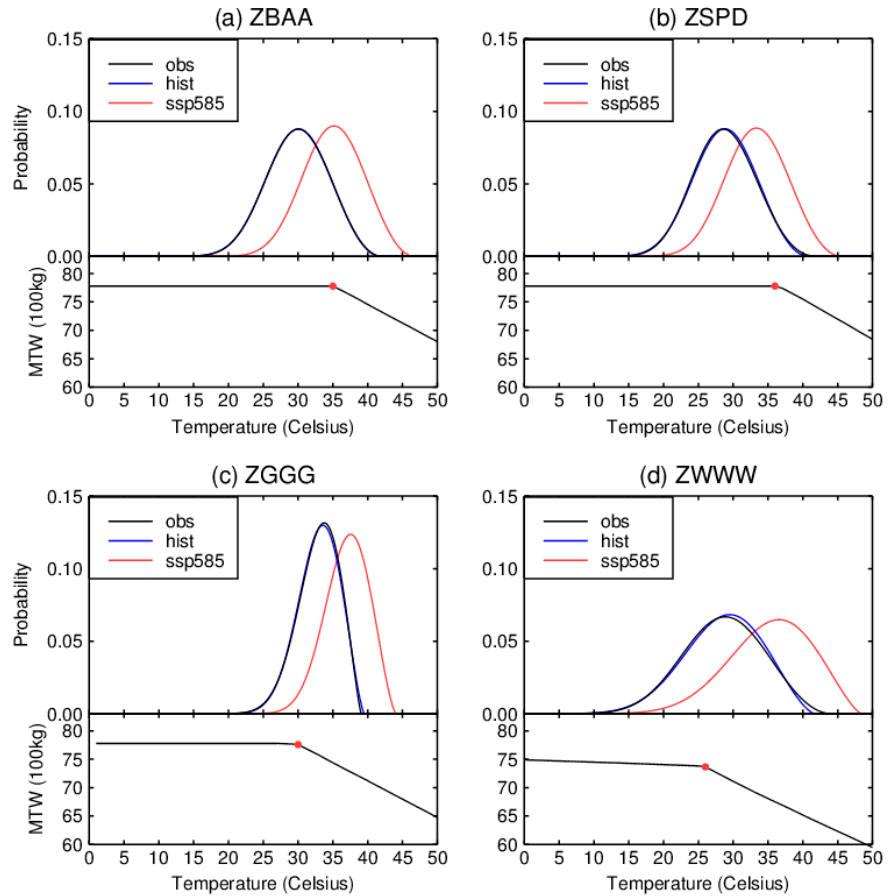
Figure 1. The upper panel of each subfigure is the generalized extreme value distributions of summer daily maximum surface air temperature at four selected airports: ( a ) ZBAA, ( b ) ZSPD, ( c ) ZGGG, and ( d ) ZWWW. Distributions are shown for the observations (black), historical simulations (blue), and projections under the SSP5-8.5 scenario (red). Note the black and blue lines are very close to each other. The lower panel of each subfigure is the relationship between MTW and tem- perature. The red dots indicate the critical temperature ( 𝑇 (cid:3030) ), defined as the temperature with the maximum second deriv- ative. The maximum takeoff weight (MTW) of an aircraft depends on a couple of factors, including surface air temperature, relative surface wind, airport elevation, and runway length. To isolate the impacts of global warming, we fix all the other parameters. The rel- ative surface wind speed is set to be zero. The dependence of MTW on surface air temper- ature is calculated using the Standard Takeoff Analysis Software, which is the operational software used by the airlines. The calculation has taken the elevation and runway length of each airport into account. The aircraft considered here is Boeing 737-800, which is one of the most common short-to-medium-range aircraft. It is also the same aircraft considered in previous studies [12,16], allowing a better comparison of the results.